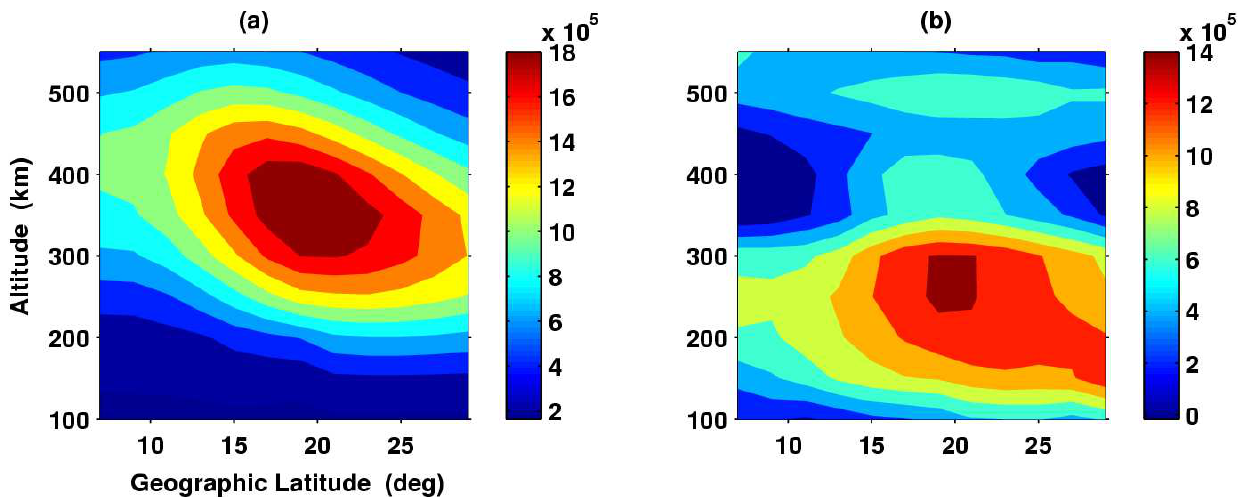
Fig. 13. ( a ) The model used to study the discretization error. ( b ) The tomographic reconstruction corresponding to Fig. 13a.